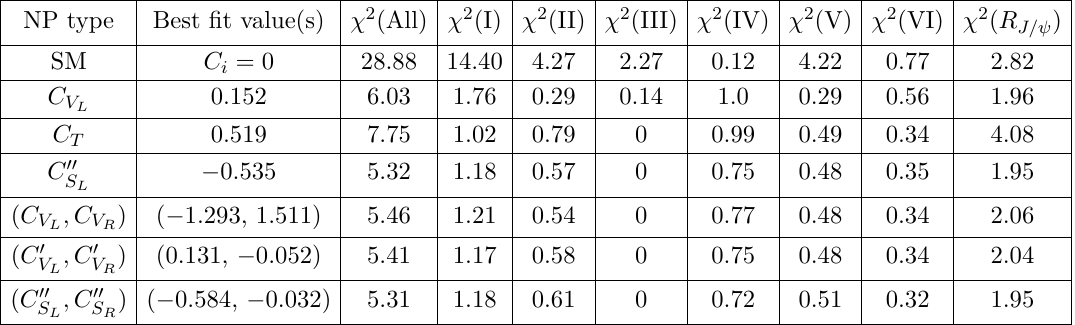
List of (cid:31) 2 values of each individual experiment for SM and for each NP